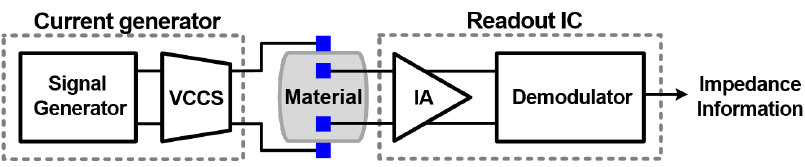
Figure 1. Overall block diagram of an EIS system.